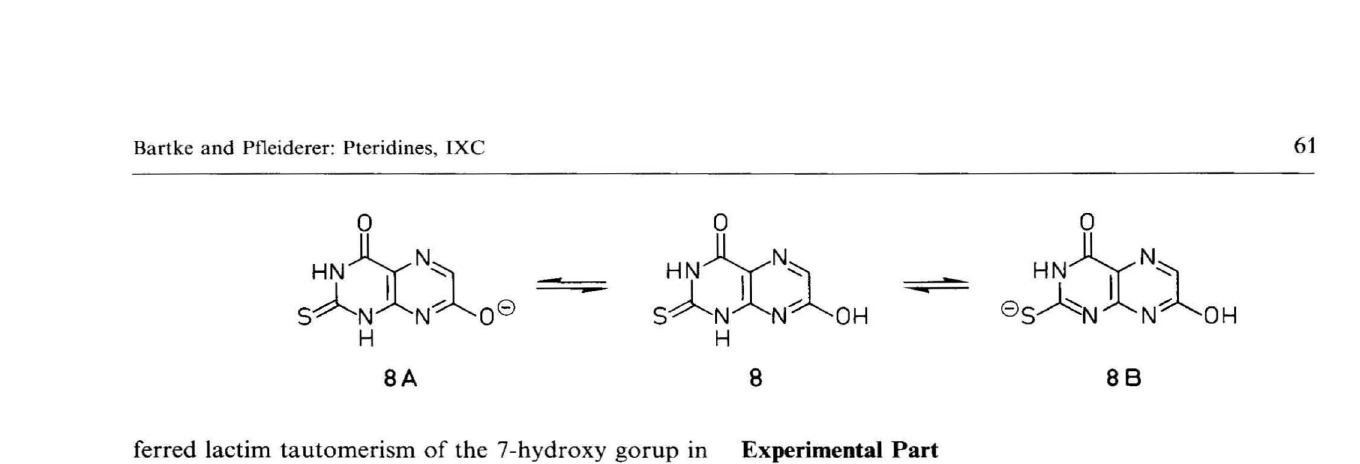
B Experimental Part General